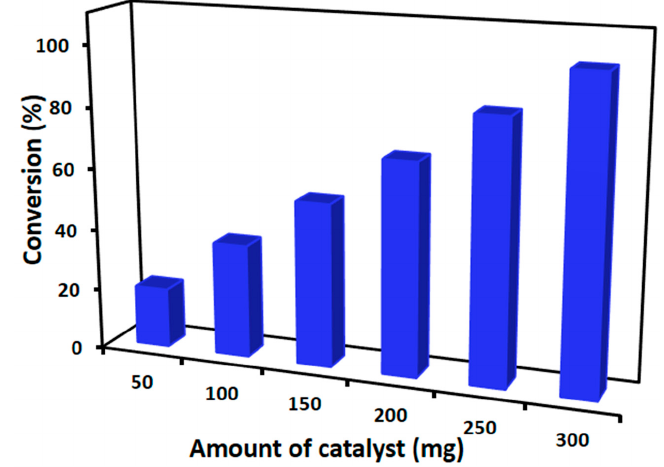
Figure 9 . Catalytic performance of ZnO x (1%)–MnCO 3 /(1%)HRG catalyst as a function of catalyst amount.